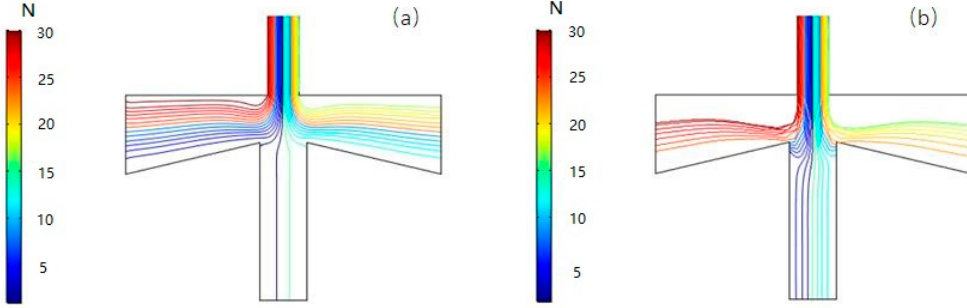
Figure 10. Pressure distribution at inlet flow rates of 2 mL/min ( a ) and 10 mL/min ( b ), respectively.